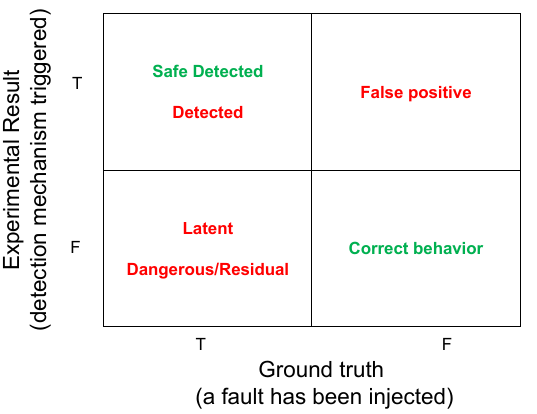
Figure 3. The confusion matrix of the proposed classification, compliant with ISO